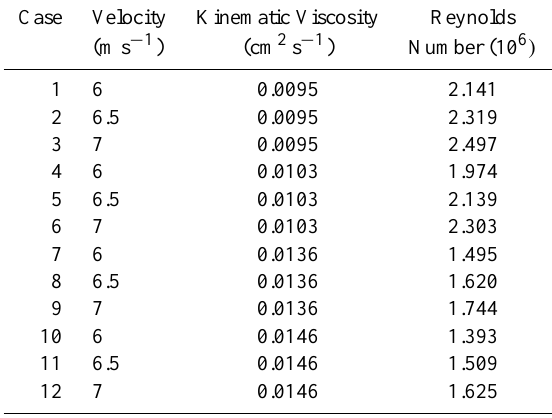
Table 1. Listing of parameters used in simulations.